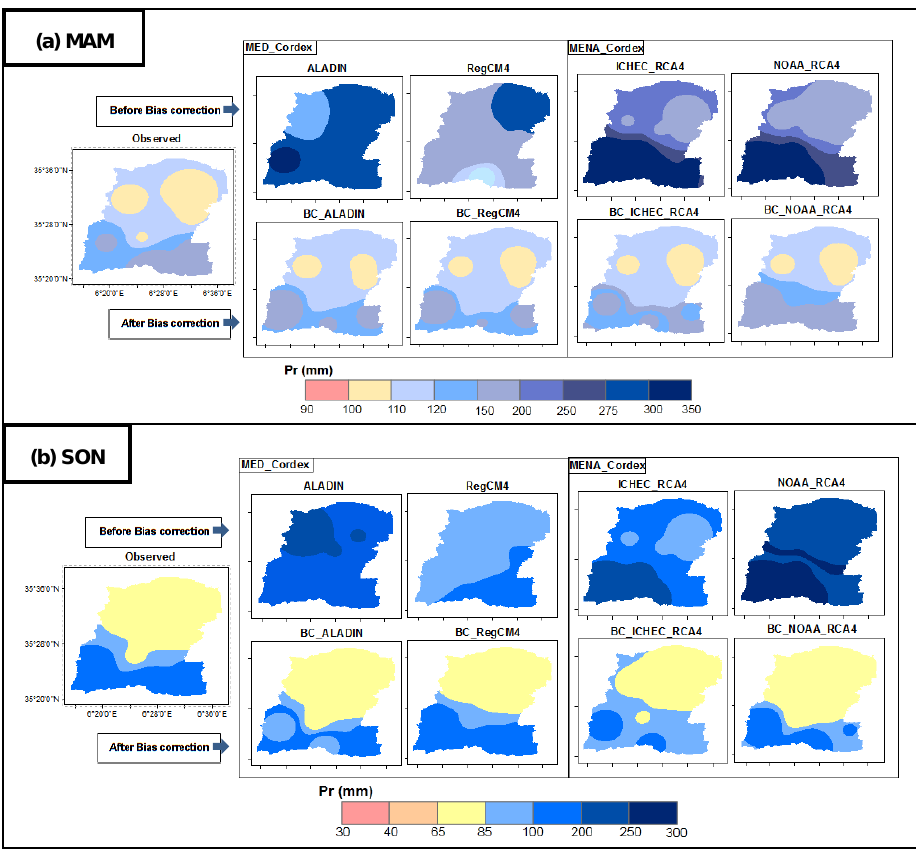
Figure 9. As in Figure 7 but for ( a ) spring (MAM) and ( b ) autumn (SON)). However, after using the GQM bias correction approach, the spatial distribution of annual and seasonal precipitation averages for corrected models (BC_RCMs) largely re- sembles the spatial distribution of averaged observation [54].